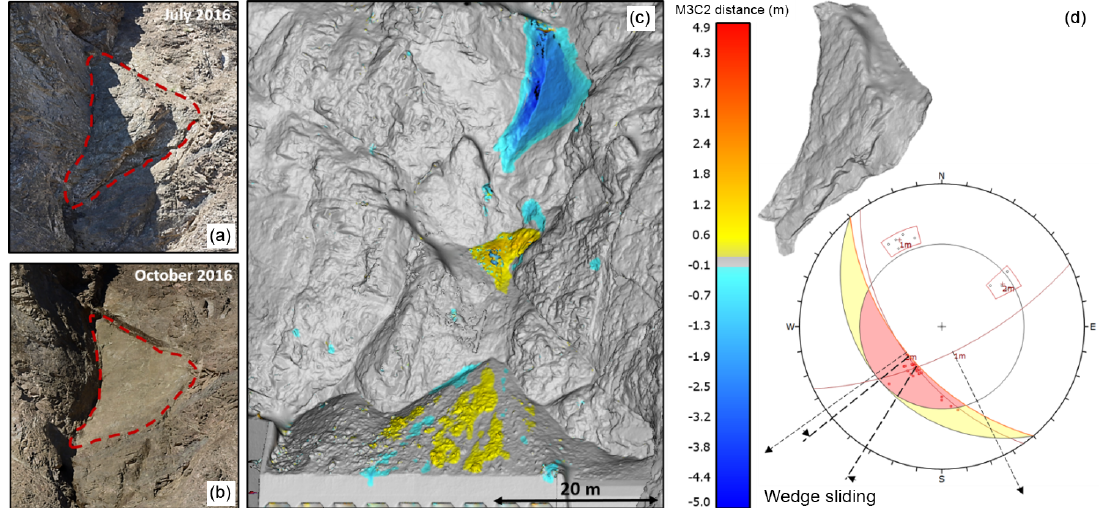
Figure 3. Site A. Visual overview of the 170m 3 wedge sliding rockfall event detected at the Goldpan site between July and October 2016. The event involved a large triangular slab of weathered and jointed rock mass which failed approximately 35m above a rock shed which is protecting the track at Goldpan. Site photos (a, b) of the source zone pre- and post-failure are shown. Change detection results of the event are shown (c) with cool colours indicating material loss and warm colours indicating material accumulation. Material from the rockfall accumulated on the bench of the mid-slope gully, as well as on top of the rock shed, with the majority of the material running out over the shed and leaving the slope. The rockfall hull of the event extracted from the pre- and post-failure meshes is shown (d) , as well as a stereonet representation of the wedge sliding failure mode.